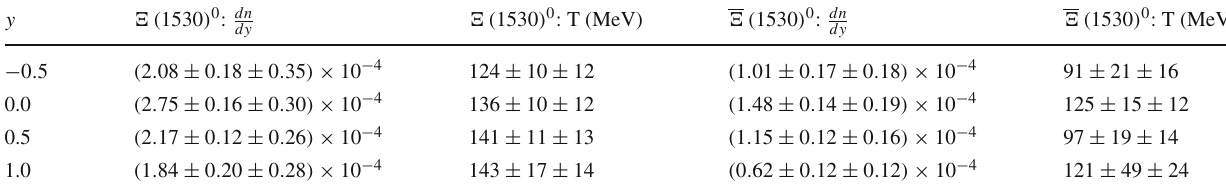
+ , and of calculated with the assumption that the uncertainties of (cid:2) and (cid:2)( 1530 ) + are independent ) in mid-rapidity in p+p interac- √ s NN = 17 . 3 GeV